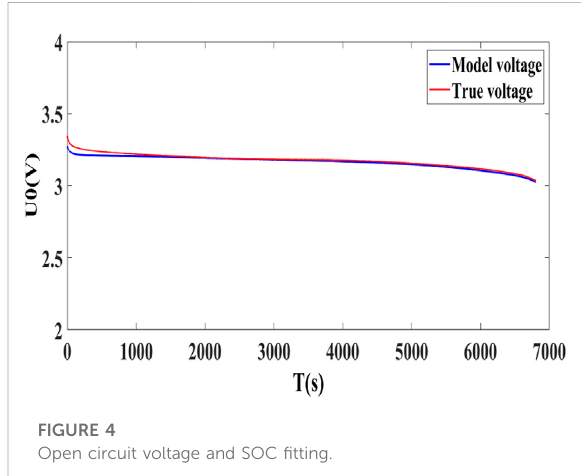
FIGURE 4 Open circuit voltage and SOC fi